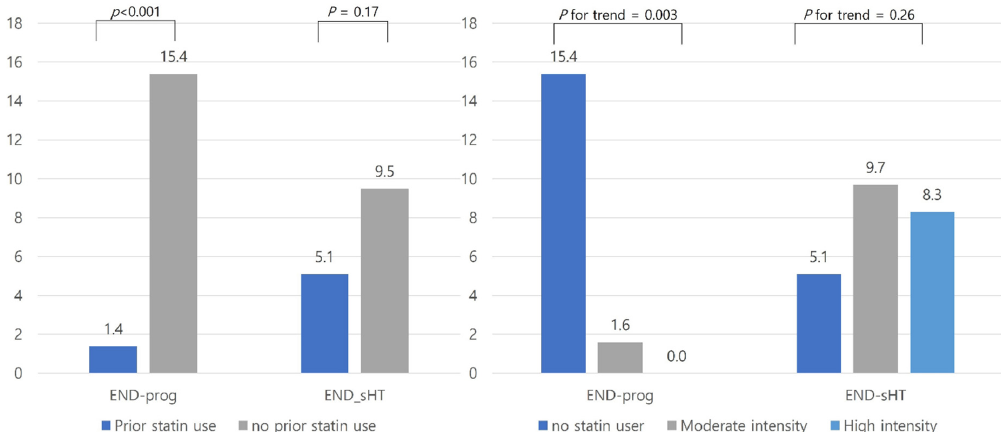
Figure 3. The proportion of occurrence of END according to prior statin use and the intensity of statins. Abbreviations: END-prog, Stroke progression; END-sHT. Symptomatic hemorrhagic transformation.